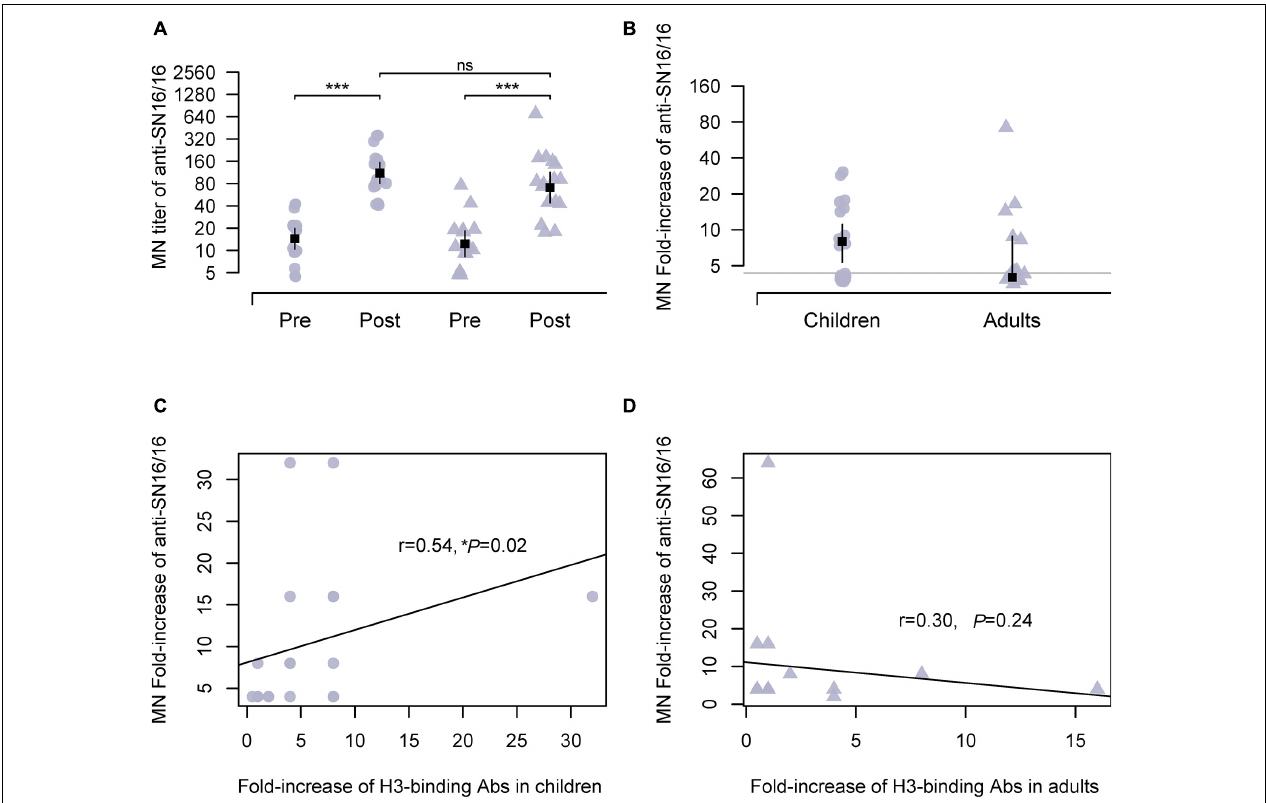
FIGURE 1 | MN Abs against circulating H3N2 virus during 2018/2019 flu season in studied children and adults and their correlations with specific HA-binding Abs. (A) Ab titer of MN Abs in the paired sera against the vaccine strain A/Singapore/INFIMH-16-0019/2016(H3N2, SN16/16). (B) Fold increase of MN Abs in paired sera against SN16/16; the gray line is the level of 4, positive conversion is fold increase ≥ 4. (C,D) Correlations between MN Abs seroconversion and SN16/16 H3-binding Abs in children and adults. (C,D) Are the regression line. The dot denotes children’s case, and the triangle represents adults. The mean ± 95% CI is shown. The r- and p -values are indicated. * < 0.05, *** < 0.001. ns denotes no significantly